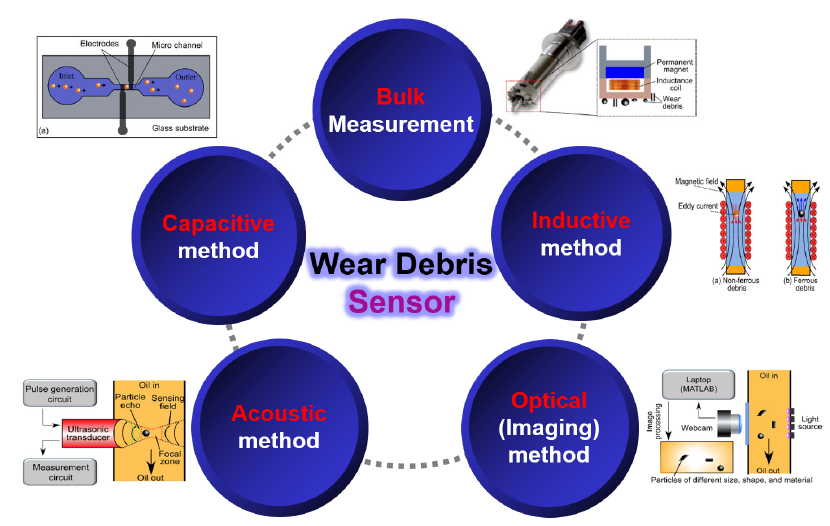
Figure 2. Various types of wear debris sensors.